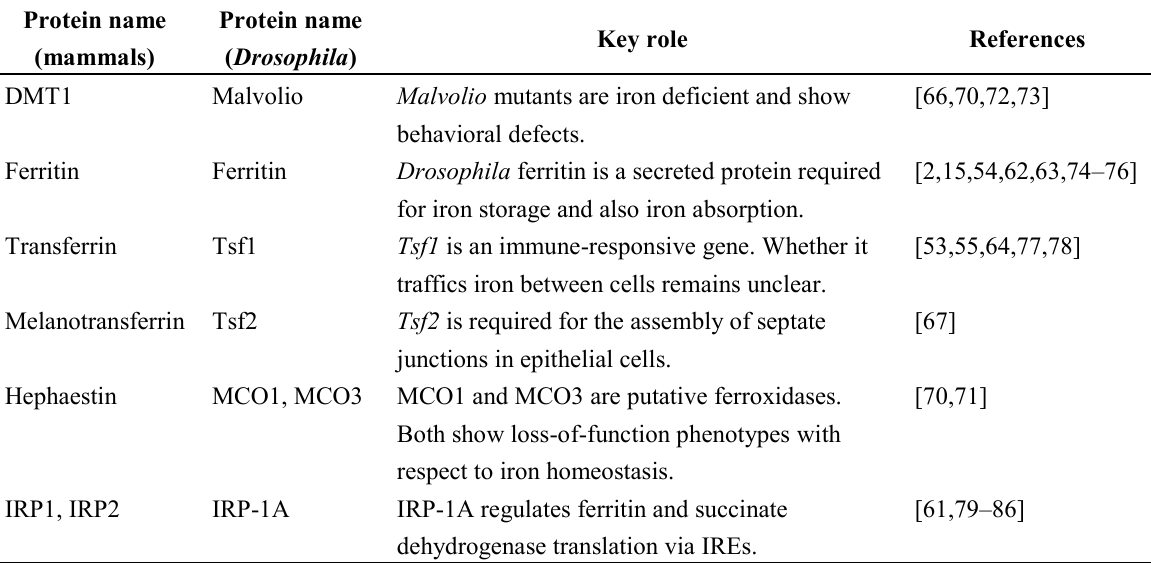
Table 1. Proteins with known functions in Drosophila iron